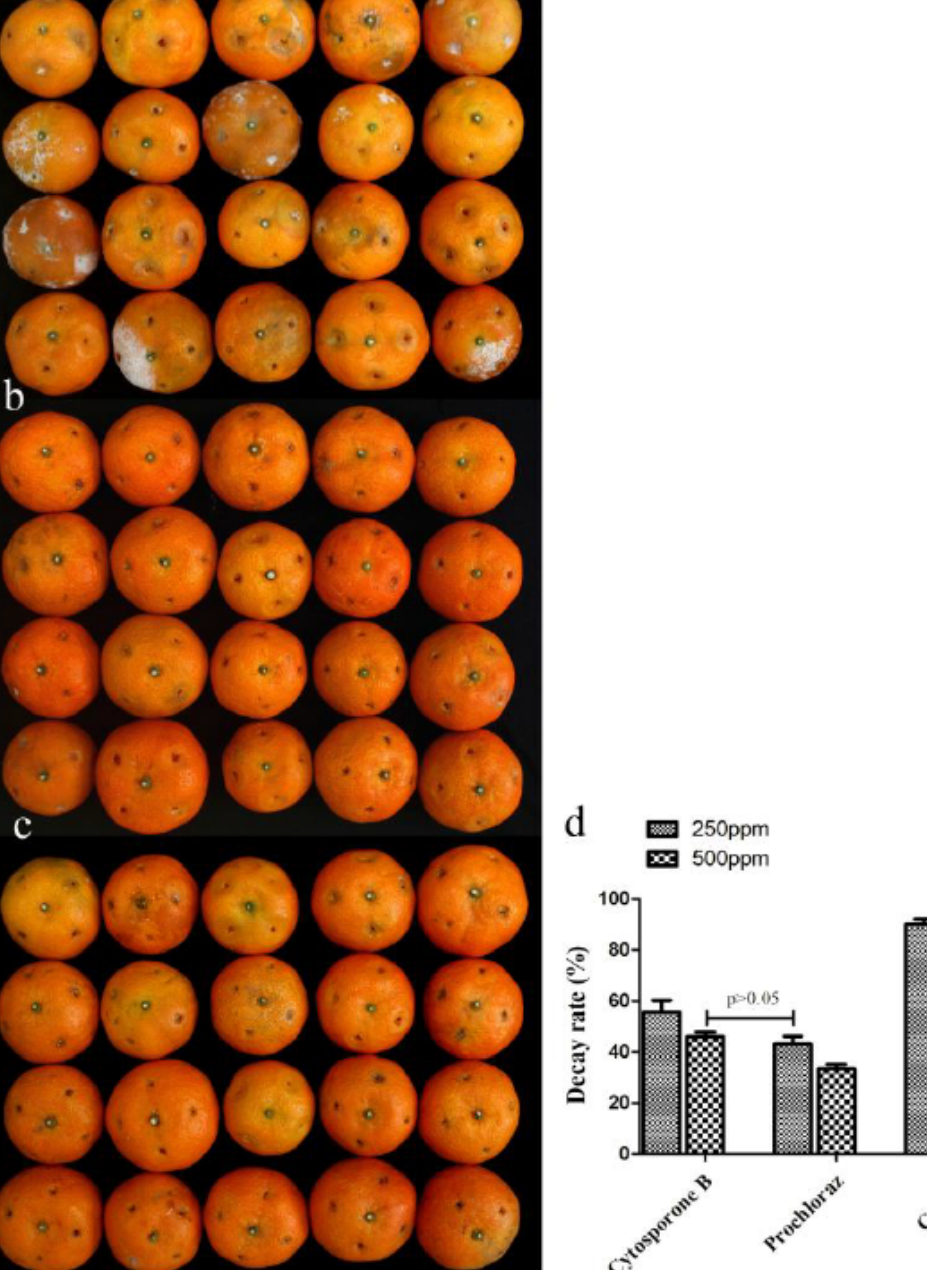
Figure 3. Influence of cytosporone B treatment on the development of Geotrichum citri-aurantii in sugar orange. ( a ) Negative control (0.1% DMSO), ( b ) cytosporone B at 500 µ g/mL(ppm), ( c ) prochloraz at 500 µ g/mL (ppm) and ( d ) percentage of the control effects. Vertical bars represent standard error of the means; p > 0.05 means no significant difference.